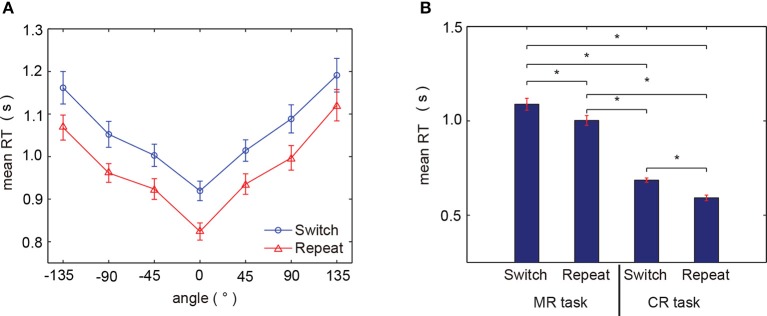
Behavioral results. (A) Mean RTs for all subjects for each presented angle (red: repeat trial, blue: switch trial). (B) Comparison of RTs between the two tasks for each trial type. MR task and CR task refer to the mental hand rotation task and command-to-response task, respectively. Asterisks (*) indicate p < 0.05 by paired t-test with FDR correction. Error bars indicate the standard error of the mean.